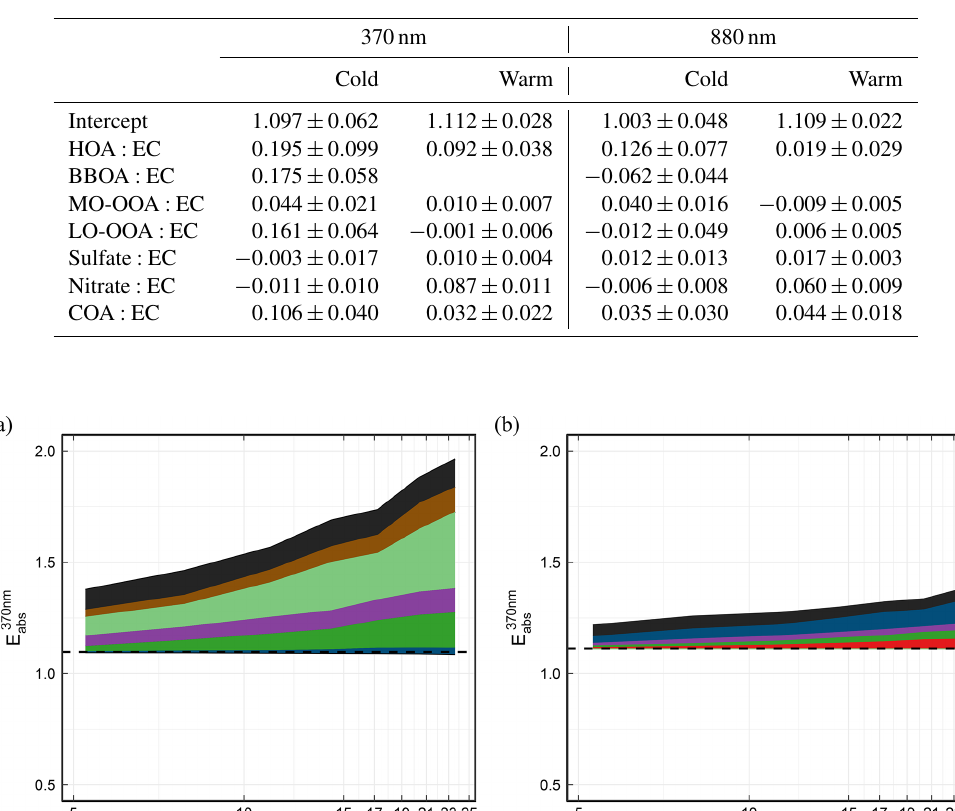
Table 3. Multivariate linear regression (mlr) analysis coefficients and standard deviation of the chemical fraction influence on the absorption enhancement, E abs , for Barcelona at both 370 and 880nm wavelengths using the Q-ACSM chemical sources (Via et al., 2021).